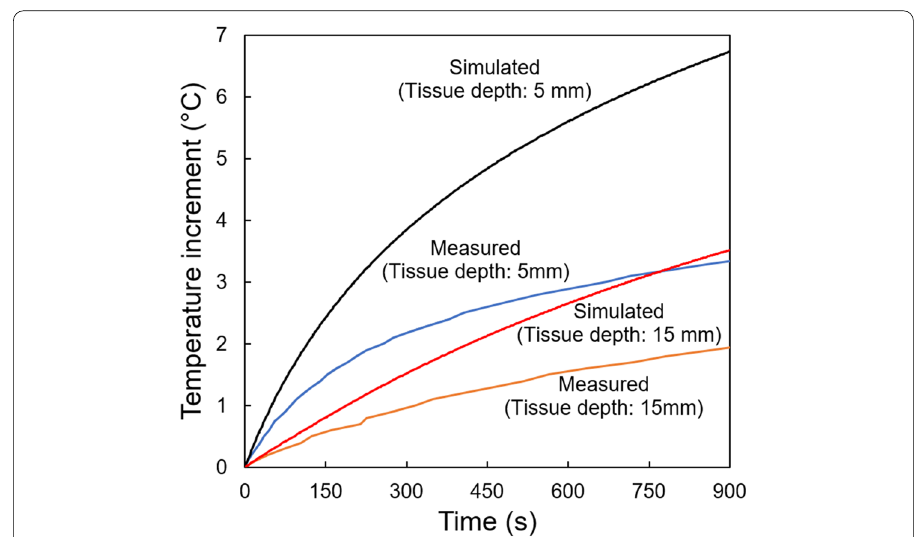
Fig. 12 Simulated and measured temperature increments at the 5 mm and 15 mm locations in the breast phantom